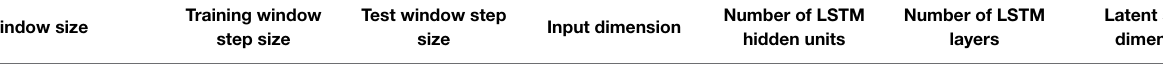
TABLE 2 | Model parameter settings. Window size